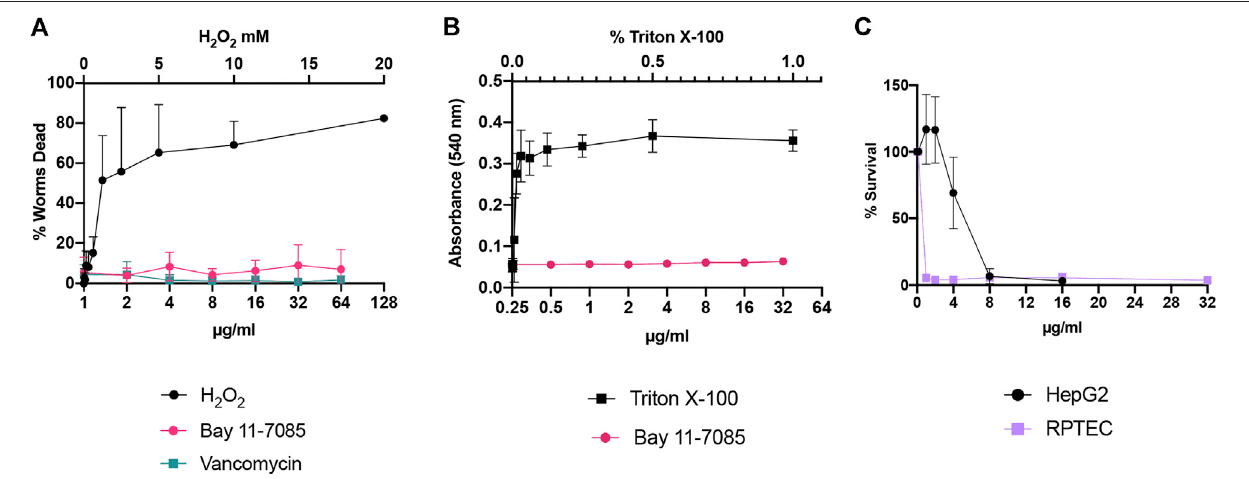
FIGURE 3 | Bay 11-7085 shows varied toxicity to C. elegans , human red blood cells, and mammalian cells. Bay 11-7085s toxicity pro fi le to (A) C. elegans , (B) human red blood cells, and (C) mammalian cells at multiple concentrations. X-axis represents concentrations of Bay 11-7085 in µg/ml. Hydrogen peroxide (H 2 O 2 ) was used as a positive control in our C. elegans toxicity assay. Triton-X 100 was used as a positive control in our human red blood cell lysis assay. ( n (cid:2) 3, ± S.D.).